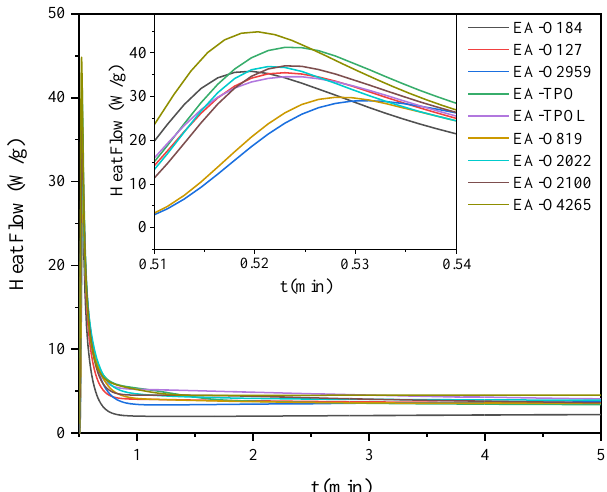
Figure 12. Photo-DSC exotherms for the photopolymerization of epoxy acrylate formulations with radical photoinitiators.